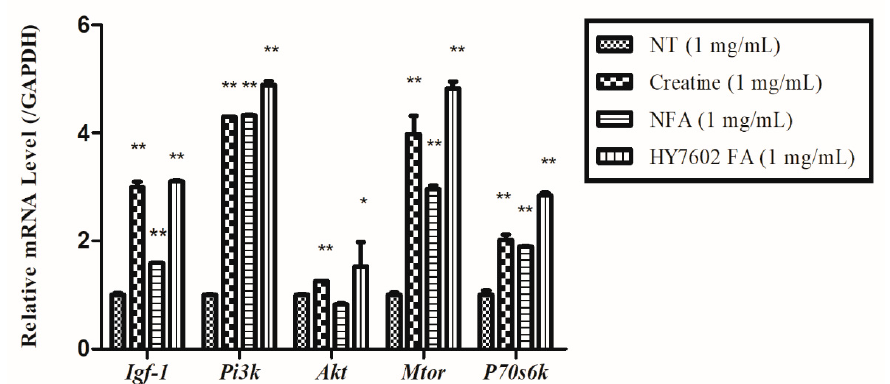
Figure 2. Effects of fermented antler (FA) on expression of IGF-1/AKT pathway-related genes ( Igf-1 , Pi3k , Akt , Mtor , P70s6k ) in mouse skeletal muscle myotubes. FA induced expression of genes related to the IGF-1/AKT/mTOR pathway. To examine expression of Igf-1, Pi3k, Akt, Mtor, and P70s6k , total RNA was prepared from C2C12 cells incubated for 24 h with NFA (1 mg/mL), HY7602-FA (1 mg/mL), or creatine (1 mg/mL). Igf-1, Pi3k, Akt, Mtor , and P70s6k were detected by using the RT-PCR program. Data are expressed as the mean ± SD of three determinations. Asterisks indicate significant differences: * p < 0.05 and ** p < 0.01 vs. NT. Akt , protein kinase B; Igf-1 , insulin-like growth factor 1; Mtor , mammalian target of rapamycin; NT, no treatment; P70s6k , phosphorylated 70-kDa ribosomal S6 kinase; Pi3k , phosphoinositide